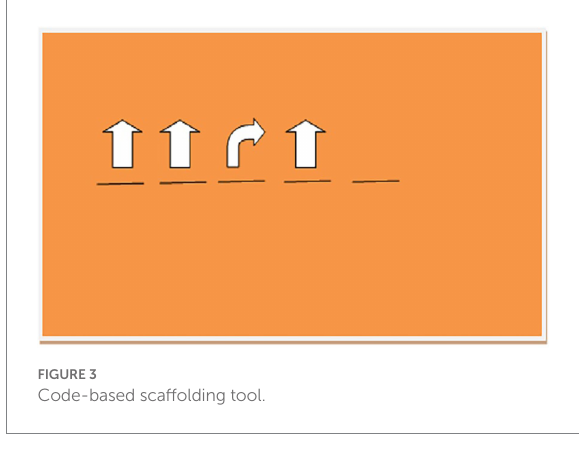
FIGURE 3 Code-based scaffolding tool.